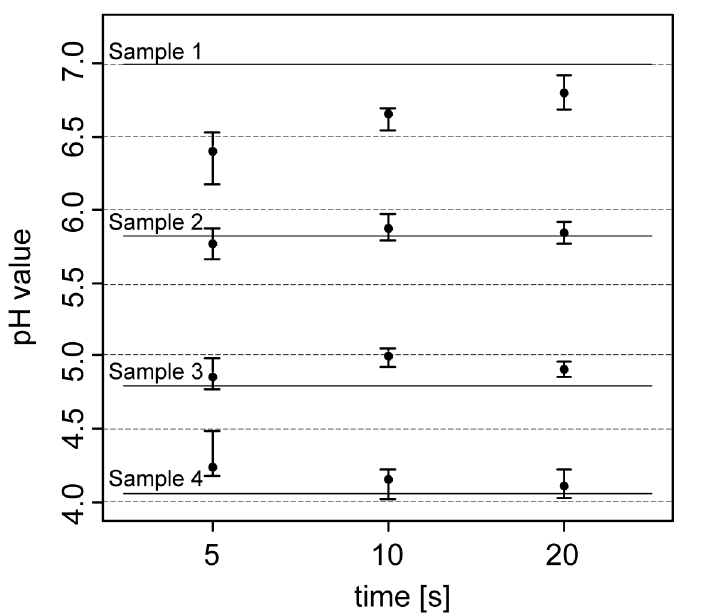
Figure 4. Soil pH measurements using antimony electrodes at 5, 10 and 20 s time intervals compared with lab reference measurements under laboratory conditions. Points correspond to the median of 10 replicates. The whiskers of the box plots display the range of the repeated measurements. The thick lines show the corresponding lab pH